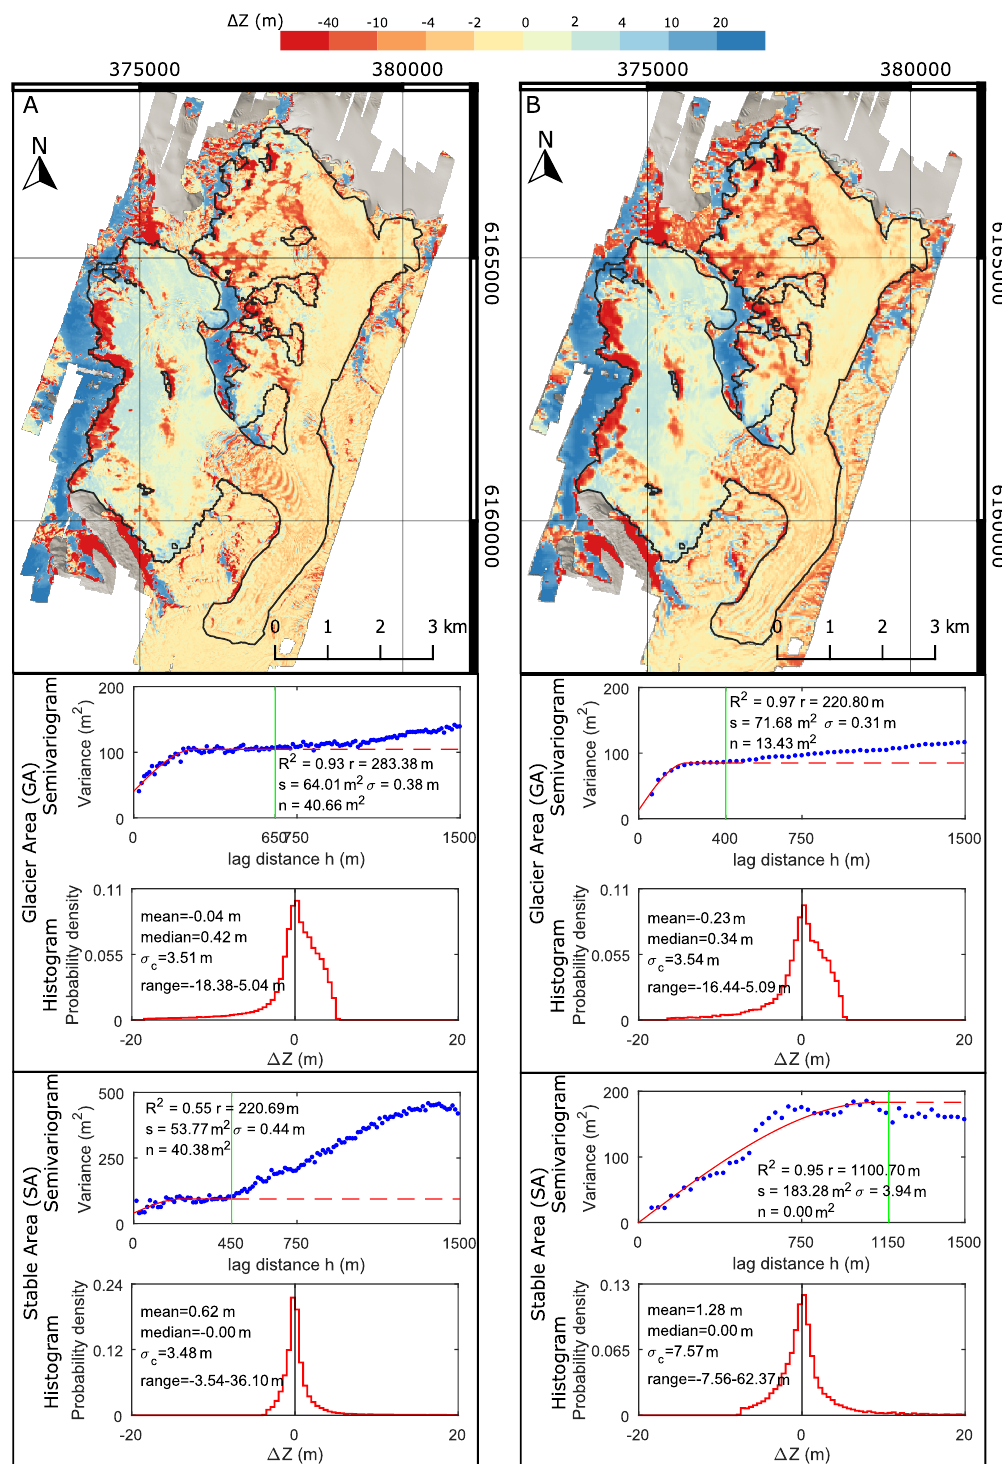
Figure 5. Results of DEM subtraction with semivariograms and histograms of differences. ( A ): ALS- TanDEM 12 m; ( B ): ALS-TanDEM 30 m. Blue dots represent empirical semivariograms, while red lines— theoretical ones. Green vertical lines indicate distance thresholds of the best fit of the model to the data. Black line on the map delimits the